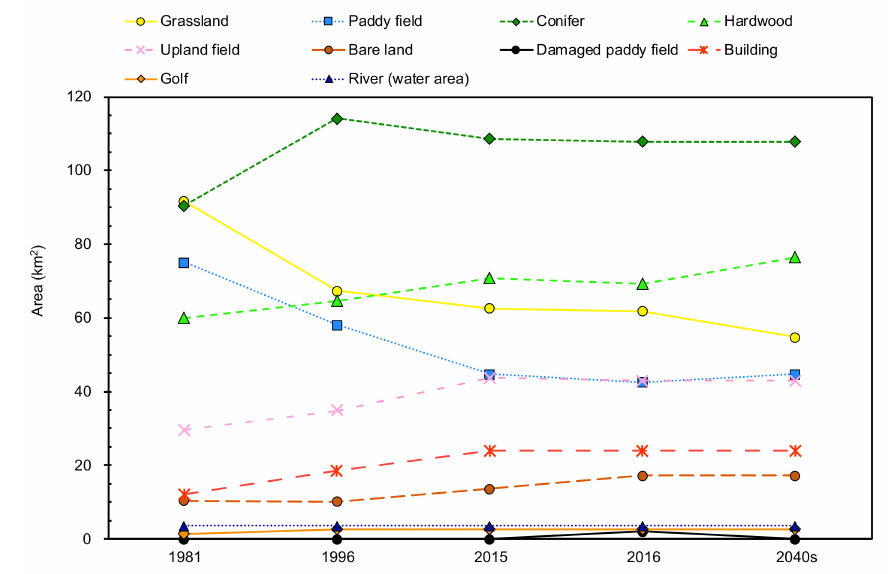
Figure 6. Temporal changes in the area for 10